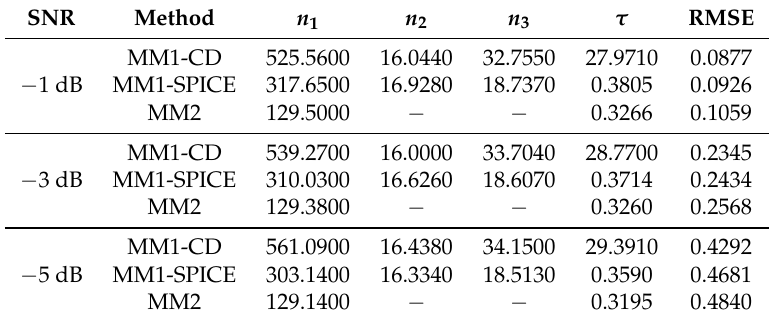
Table 1. Comparison of computational complexities and